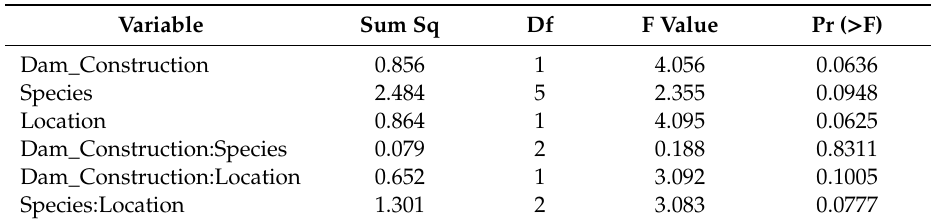
Figure 9. Effect plot showing the estimated mean EIR of malaria vectors in Nyabessan and Olama before versus during dam construction. A. gb : Anopheles gambiae s.l. ; A. ms : Anopheles marshallii ; A. mc : Anopheles moucheti ; A. ov / ni : Anopheles ovengenesis of A. nili ; A. pl : Anopheles paludis ; A. zi : Anopheles ziemanni. Table 5. ANOVA table for the model of entomological inoculation rate (EIR) as a function of periods before and during dam construction, location, and